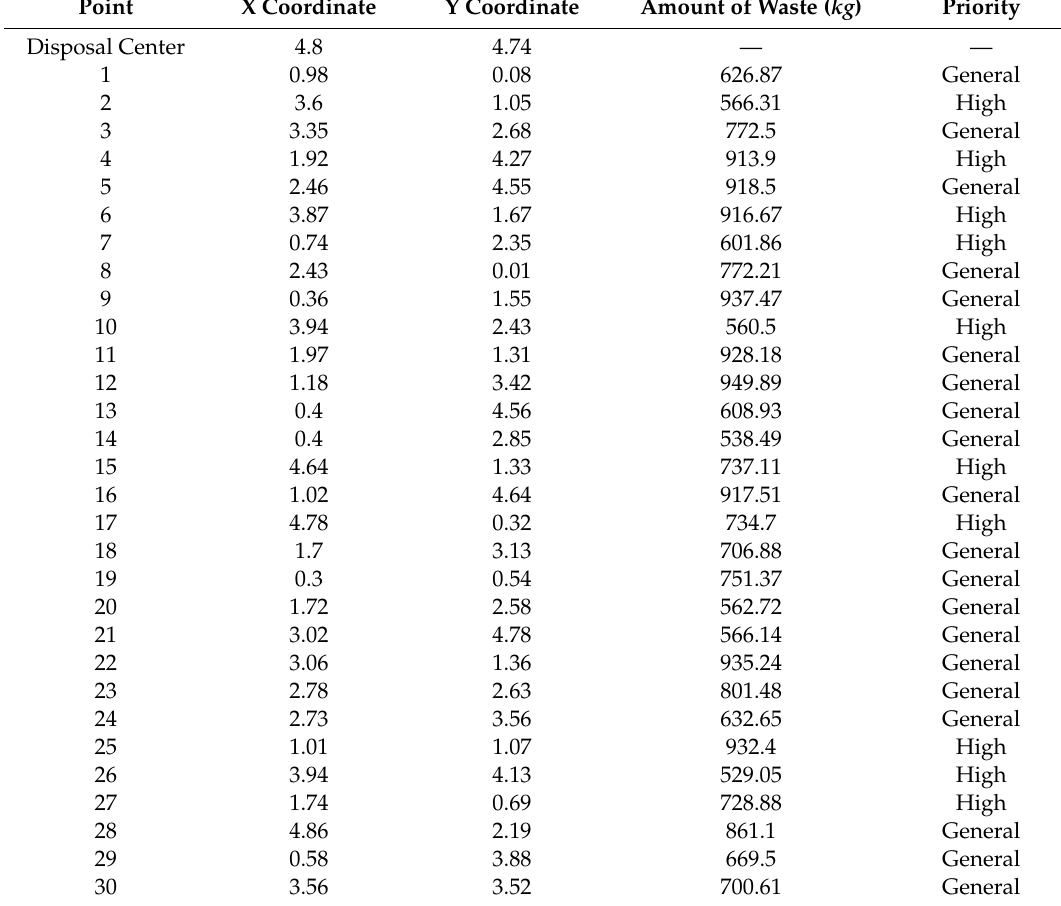
Table 9. Information about the disposal center and waste bins.